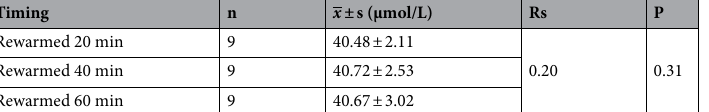
Table 7. GABA values of brain extracellular fluid in different rewarming time groups (μmol/L). There was no a significant correlation between different rewarming times and GABA values. **When the confidence (bilateral) is 0.01, the correlation is